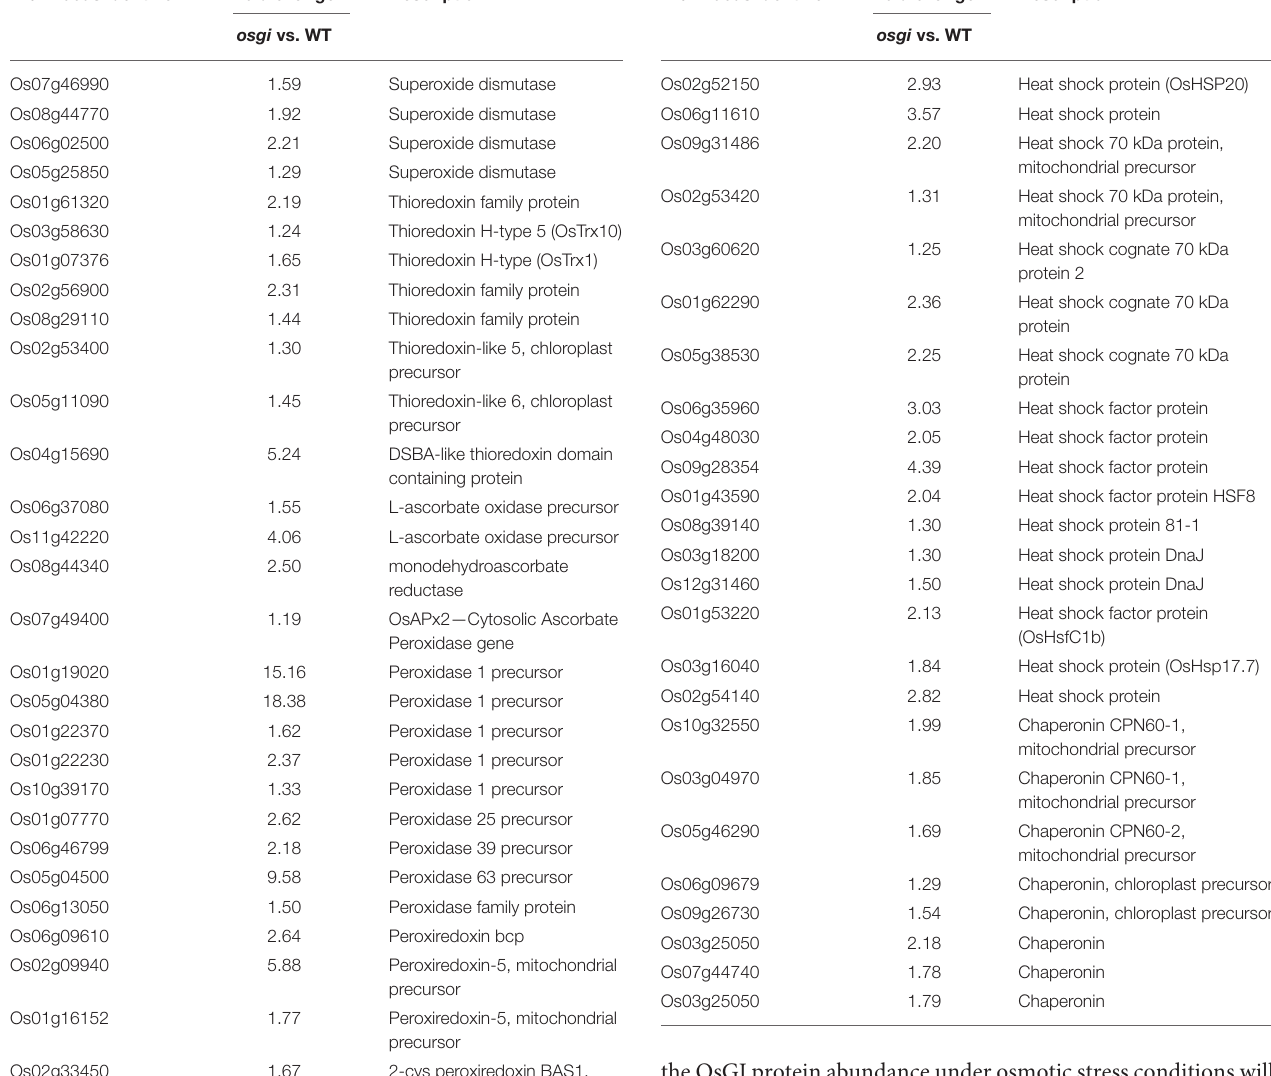
TABLE 3 | Genes involved in chaperone synthesis with significantly different transcript abundance in osgi vs. WT leaves ( p < 0.05). TIGR locus identifier Fold change